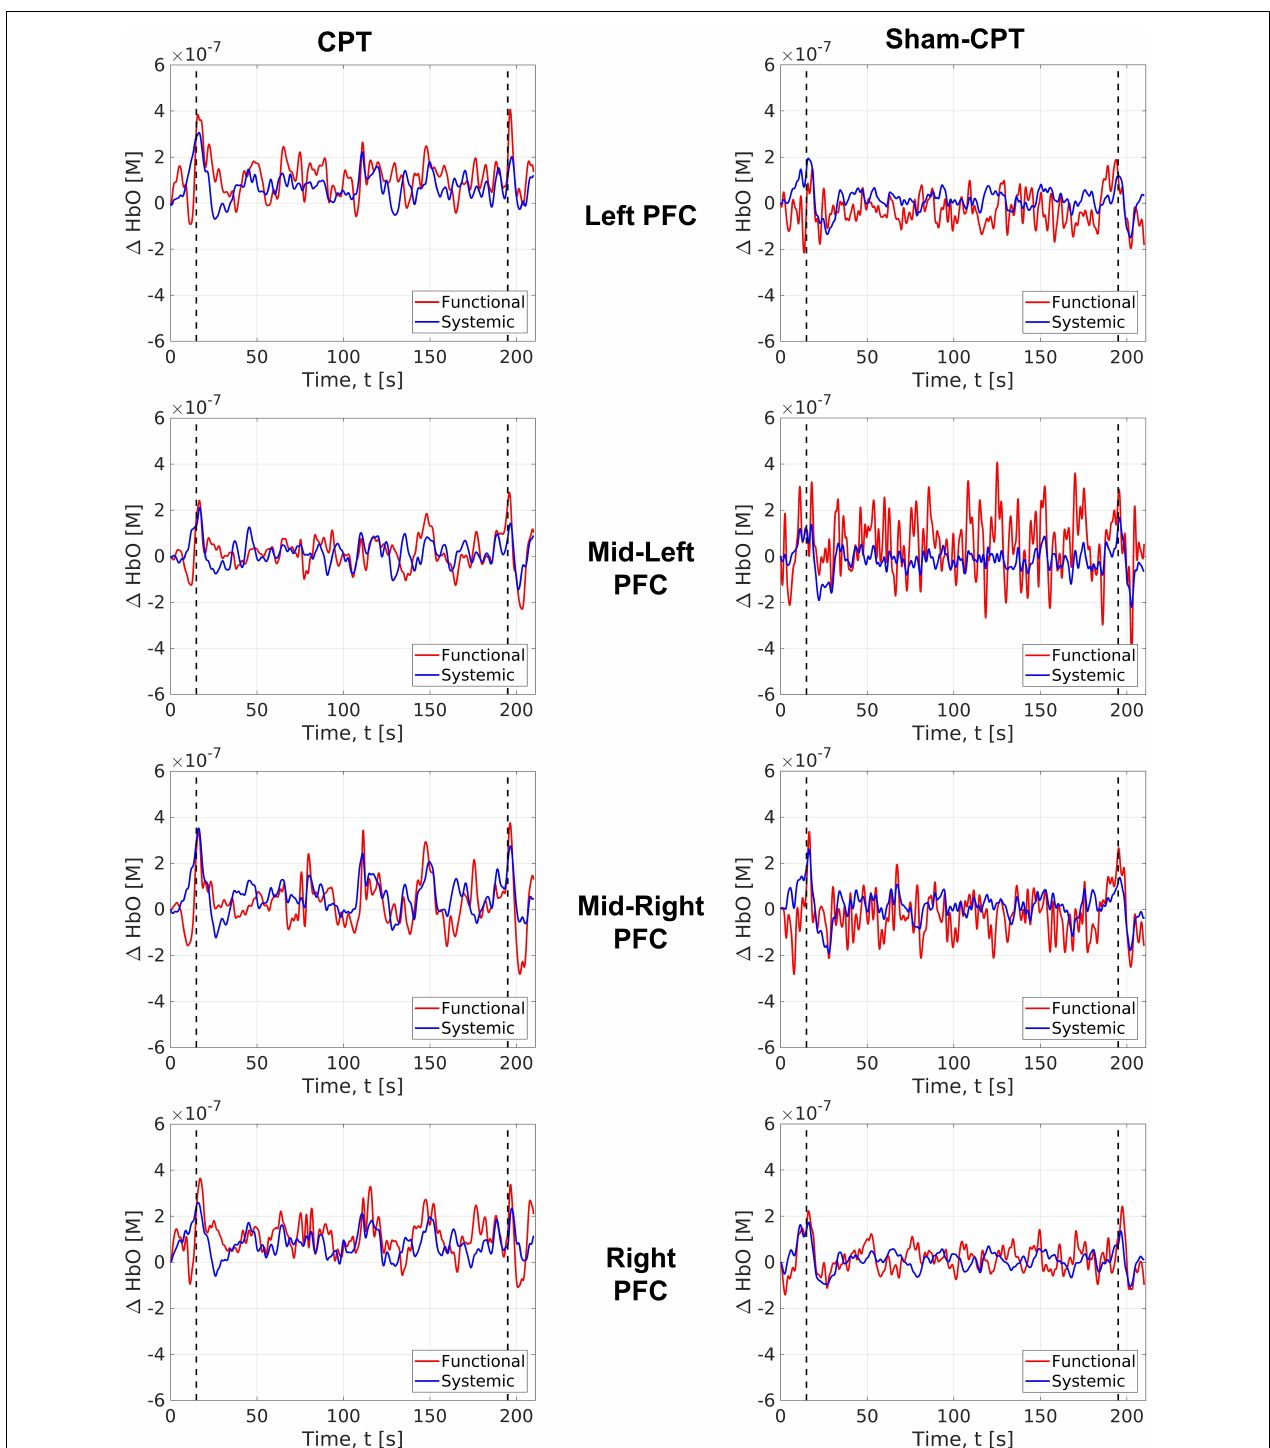
FIGURE 5 | OxyHb levels in the cortical areas (or functional changes) represented by red curves vs. OxyHb levels in the scalp/skull areas (or systemic changes) identified by blue curves. Values represented are averaged across participants in the Stress group (left column) and Control group (right column). The X -axis presents the duration of measurement (i.e., time). The Y -axis presents the measured levels of OxyHb. 0 in the Y -axis represents the start of measurement of OxyHb levels; all changes are assessed relative to this quantity of OxyHb. Top row represents these changes in the Left-PFC region (channels 1–5). Second row represents changes in the Mid-Left-PFC (channels 6–10). Third row represents changes in the Mid-Right-PFC (channels 11–15). Last row represents changes in the Right-PFC (channels